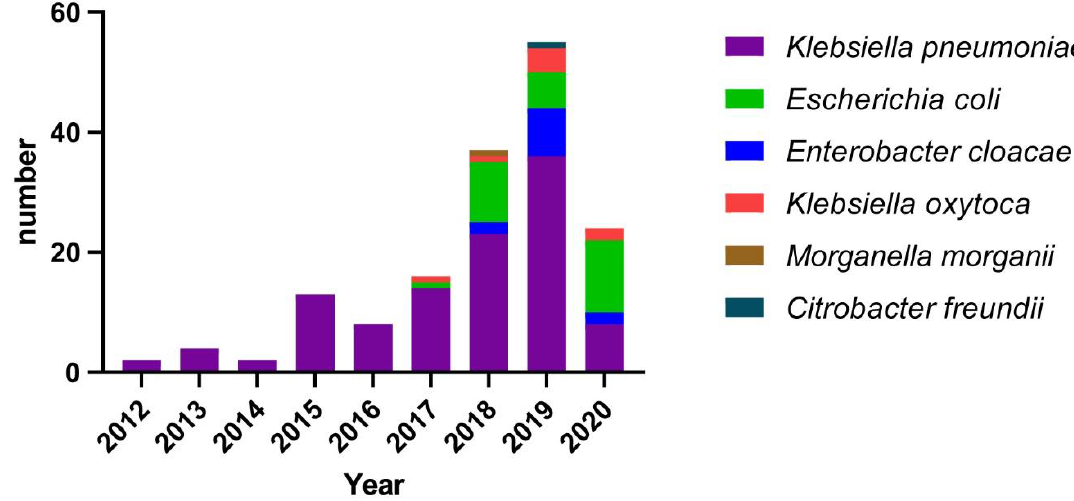
Figure 1. Species distribution of all carbapenem-resistant Enterobacterales strains from 2012 to 2020 in this